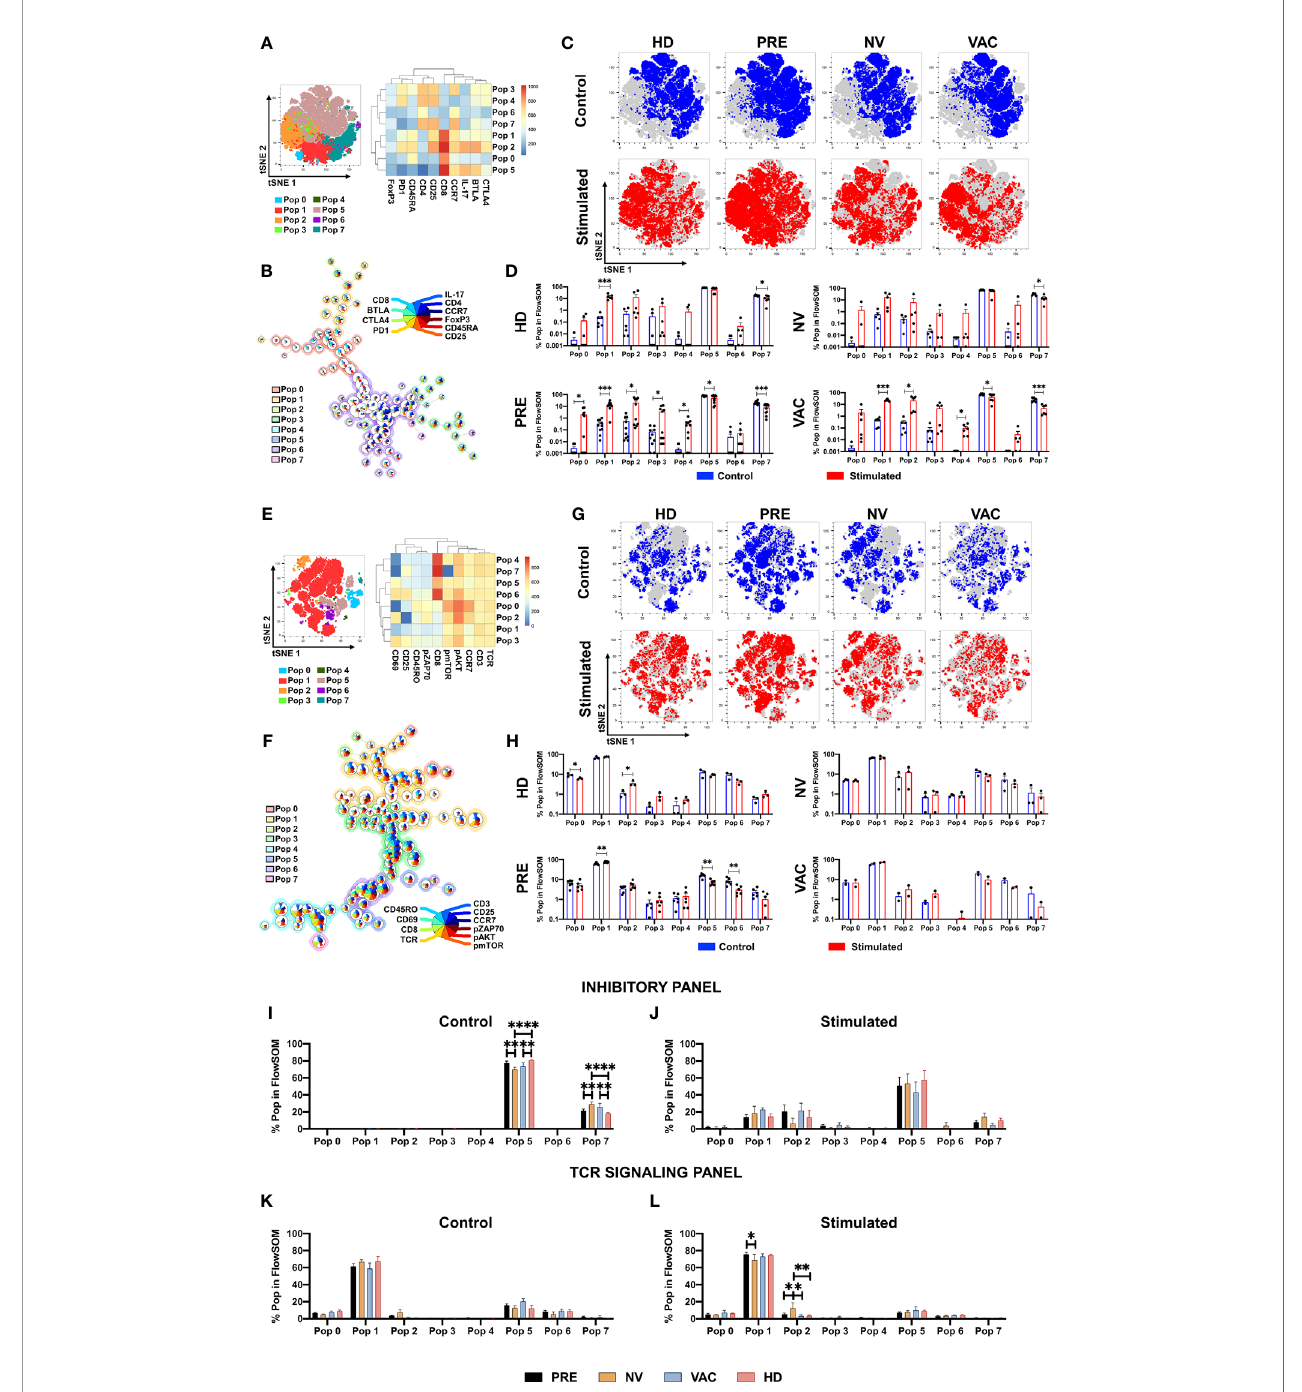
FIGURE 4 | Identi fi cation of T-cell populations associated with dendritic cell (DC) transfer by FlowSOM. FlowSOM analysis of two different staining panels, inhibitory (A – D) and T-cell receptor (TCR) activation (E – H) . tSNE plots of concatenated samples with the relative location of the eight populations determined by FlowSOM with their respective heat map of each marker (A , E) . Spanning tree of the FlowSOM populations with their respective pie chart (size of each circle is proportional to cell frequency) (B , F) . Distribution of stimulated (red) and control (blue) samples in tSNE plot of each patient group (C , G) . Relative cell frequency in each population for the individual groups between stimulated (red bars) vs. control (blue bars) (D , H) . Direct comparison of the relative cell frequency among groups for the FlowSOM analysis in inhibitory panel ( I , control; J, stimulated) and in the TCR panel ( K , control; L , stimulated). Non-parametric Mann – Whitney test between populations or groups. *p < 0.05, **p < 0.01, ***p < 0.001, and ****p <